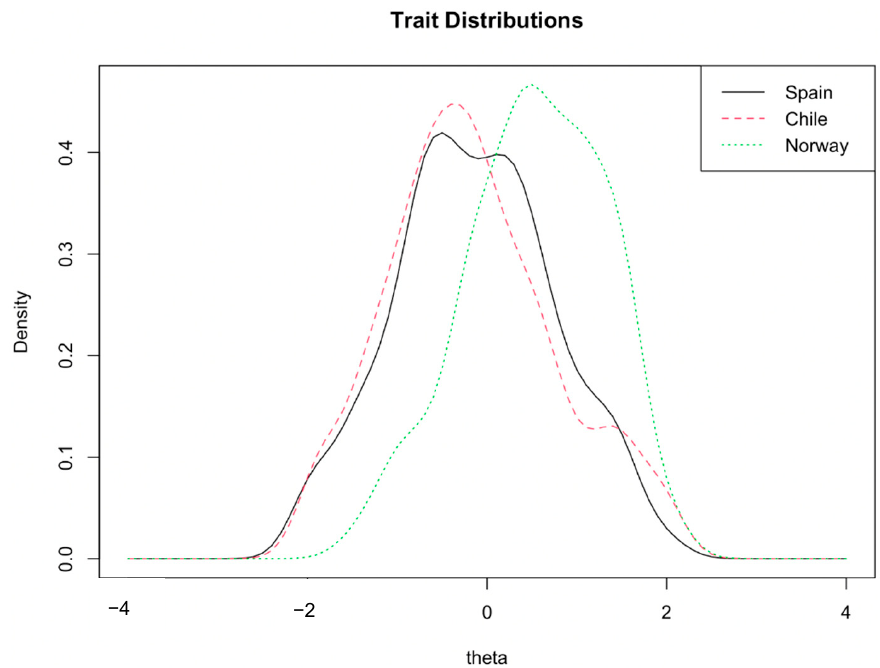
Figure 1. Graphic representation of the population latent trait distribution in the three countries.